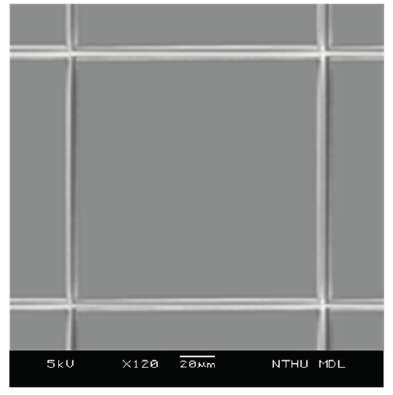
Figure 3. Fabrication processes of the sensor; ( a ) after the completion of the CMOS process; ( b ) etching of the sacrificial lays; ( c ) sealing the etch holes.